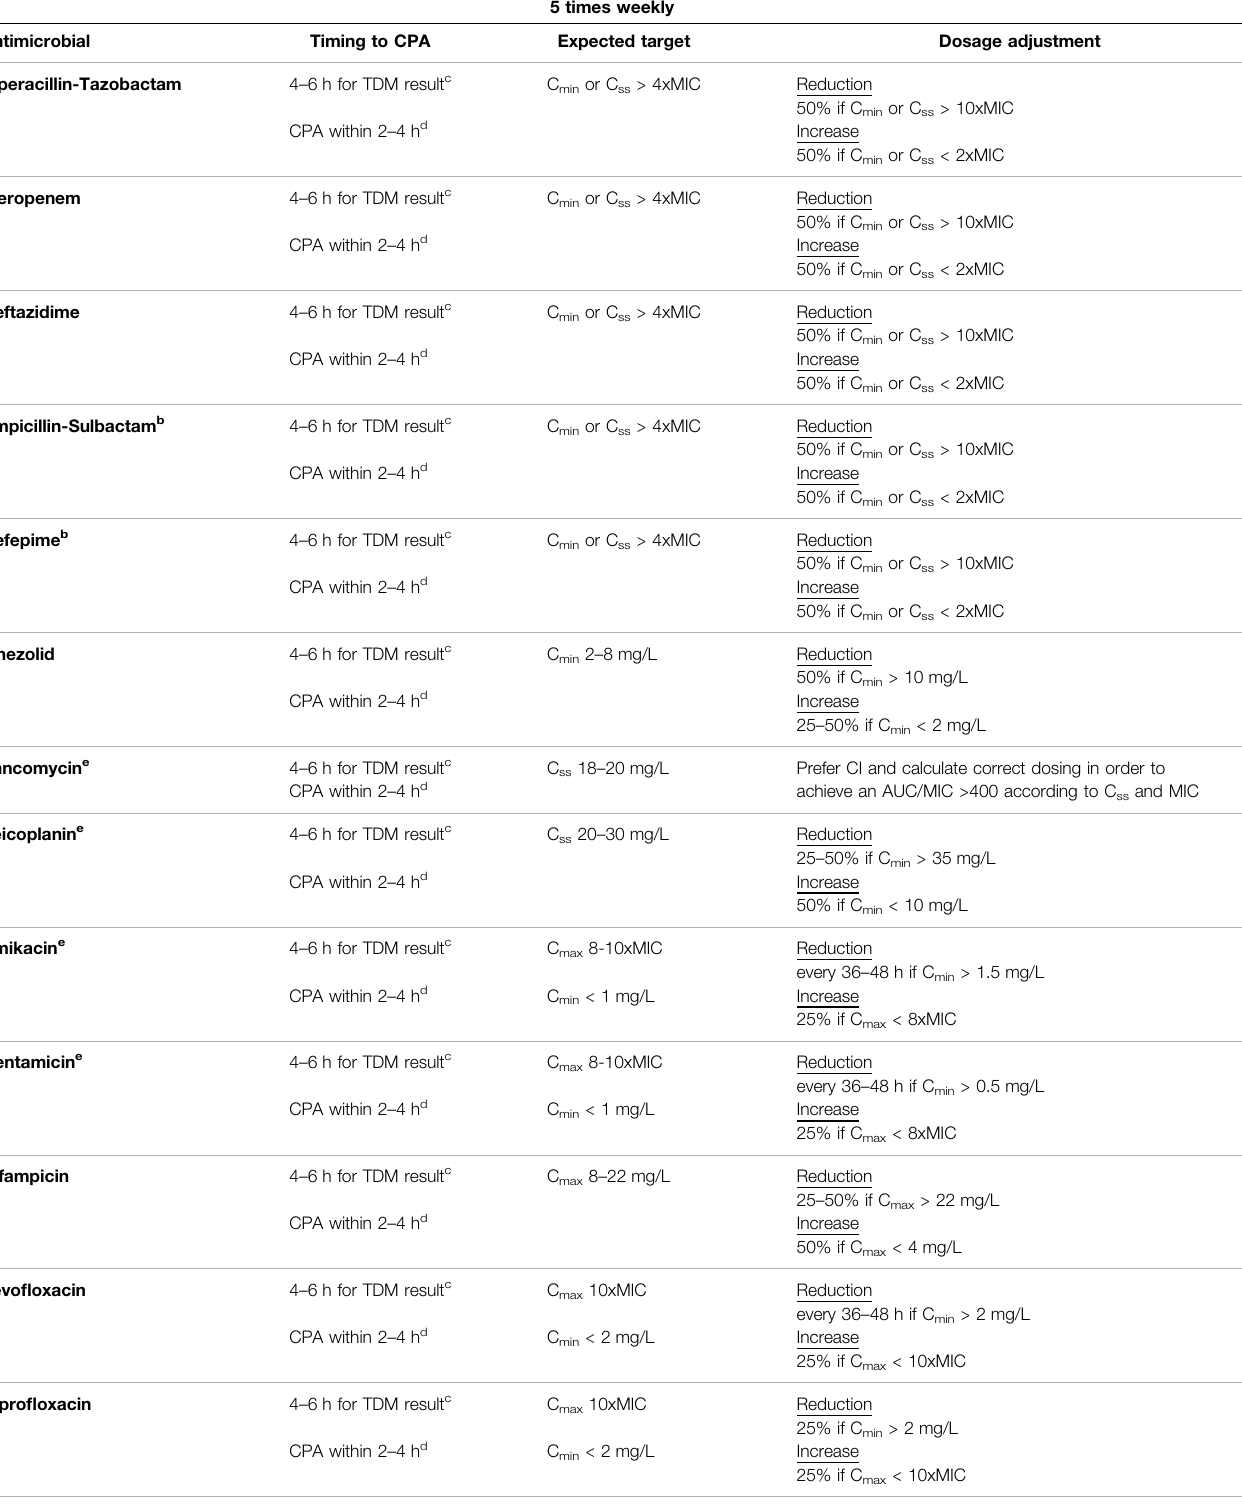
TABLE1| Scheduledtiming,expectedPK/PDtarget,andTDM-guideddosageadjustmentsofantimicrobialsforwhichclinicalpharmacologicaladviceisavailable fi ve-times